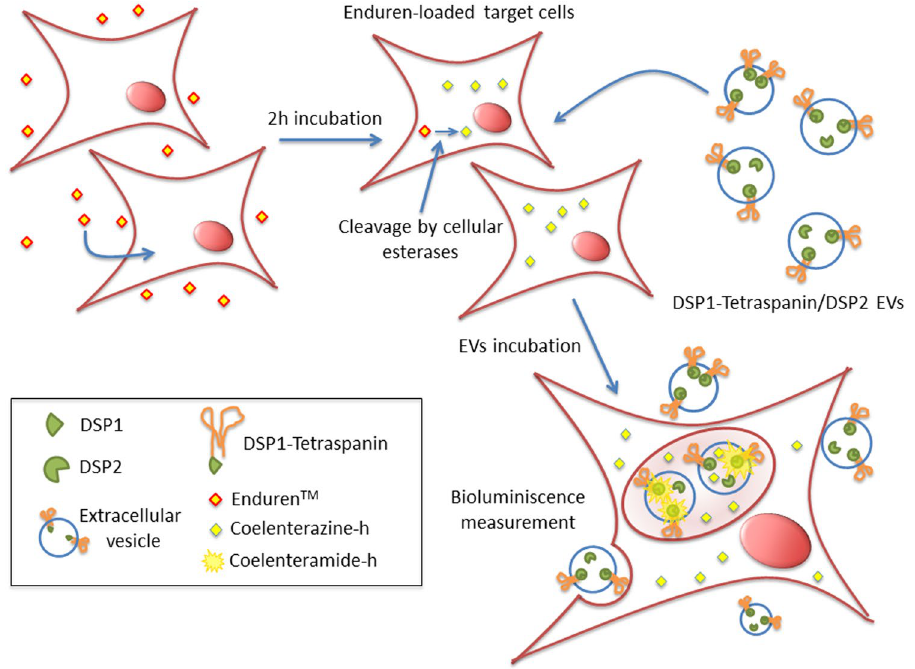
Figure 7. Scheme of the EV uptake assay. First, receptor cells are preloaded with Enduren, a cytopermeable protected Renilla luciferase substrate. Once internalized, Enduren is processed by intracellular esterases, rendering Coelenterazine-h Renilla luciferase substrate. EVs are isolated from cells that stably-express both DSP2 and either DSP1-CD9 or DSP1-CD63, and thus carrying fully competent Renilla enzyme. Only those EVs that are taken up by target cells and internalized will gain access to the deprotected Renilla luciferase substrate and will transform it into Coelenteramide-h, which emits the luminescence